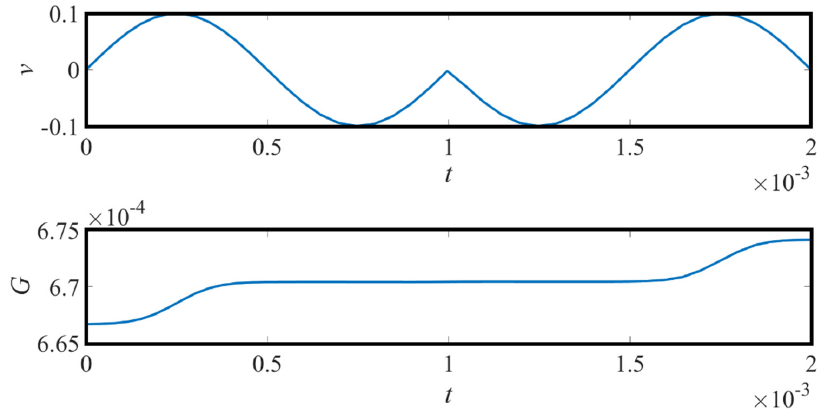
Figure 5. memristor conductance is a strong function of the input signal phase. Figure 5. Memristor conductance is a strong function of the input signal phase. BPSK demodulator, respectively, and Table 3 shows the relevant parameter values. Alt-